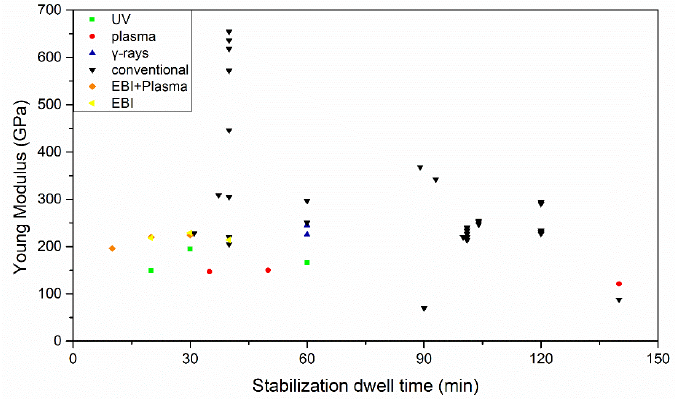
Figure 6. Young modulus versus stabilization duration based on literature data presented in Figure 3.